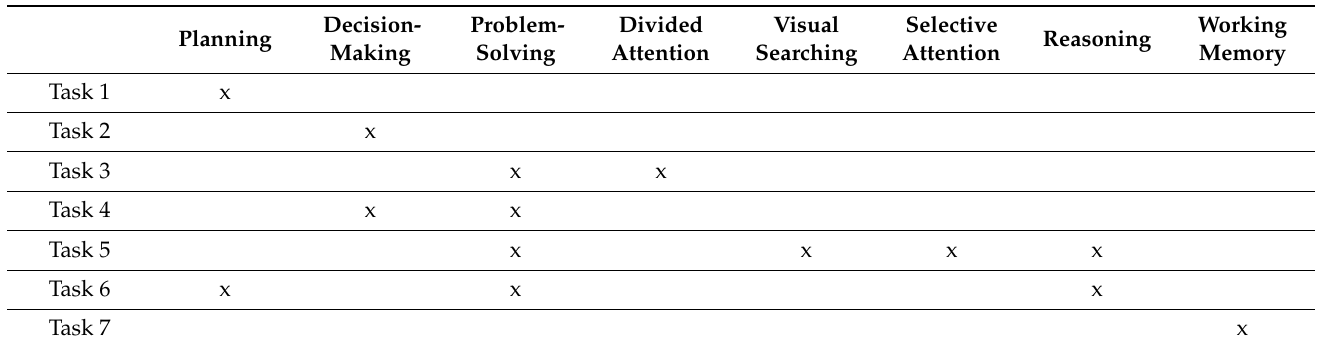
Table 1. Subtasks and related executive